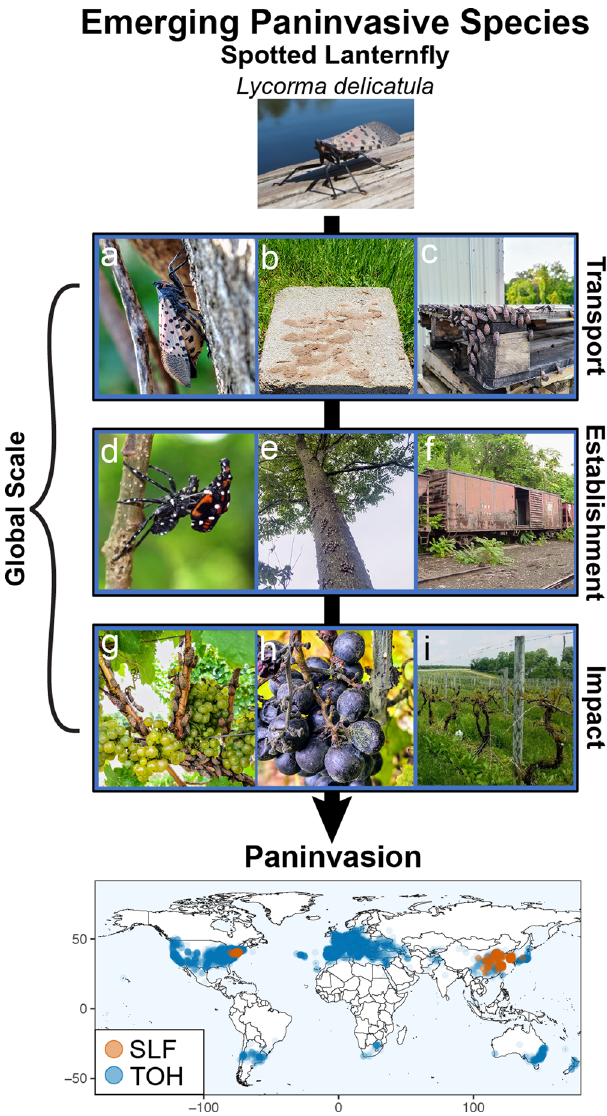
Fig. 1 The concept of paninvasive species is based on invasion process theory. Any species has potential to complete three sequential stages (depicted by the arrow) to become invasive in a region (i.e., transport to the region, establishment in the region, impact on the region ’ s economy) 2 . For a pest paninvasion to occur, a pest must be transported and established in suitable regions globally where it impacts susceptible agriculture, disrupting markets at a global scale (depicted by the bracket). Here, we focus on estimating invasion stage potentials for the spotted lantern fl y planthopper ( Lycorma delicatula , SLF), an emerging U.S. pest at risk of disrupting the global wine market. Photos introduce SLF biology. Gravid females ( a ) lay eggs on many surfaces like stone ( b ) and transport infrastructure ( c ). Once eggs hatch, SLF develop by molting through three black and one red nymphal instars ( d ) before molting into winged adults (top, a ). SLF feed on phloem of many plants but develop quickly on tree of heaven ( Ailanthus altissima , TOH, e , f ), a globally invasive tree commonly found in habitat fragments around railroads ( f ) and warehouses ( c ). SLF also heavily feed on grape ( g ), reducing yield ( h ) and contributing to vine death ( i ). Photo credits: S. Cannon ( e ), M. Helmus (top, a , d ), H. Leach ( b , c , g – i ), G. Parra ( f ). The map is of SLF (orange) and TOH (blue) presences (ca. 2020) we used to estimate paninvasion risk (see